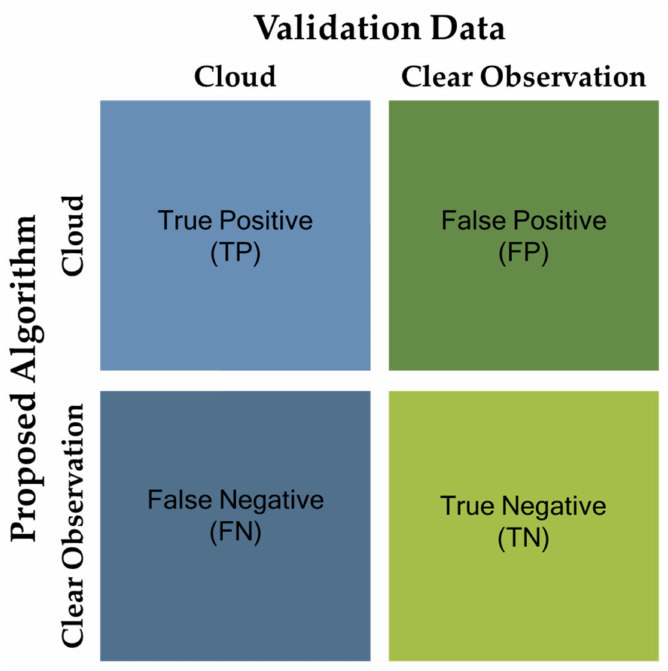
Figure 8. Confusion